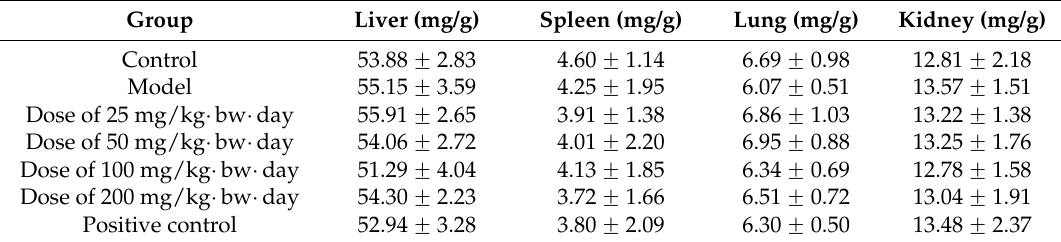
Table 4. Effect of Maydis stigma (FMS) on organ weights in mice.